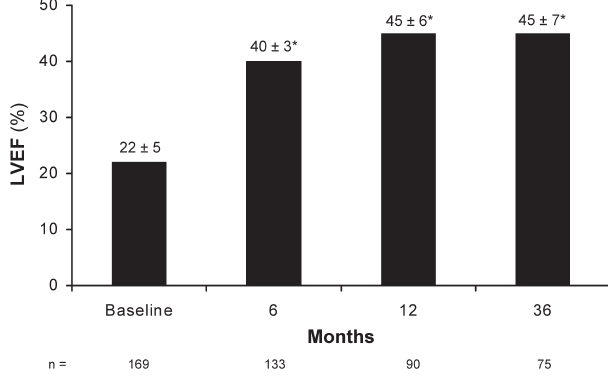
Figure 1 - Left ventricular ejection fraction (LVEF) determined by